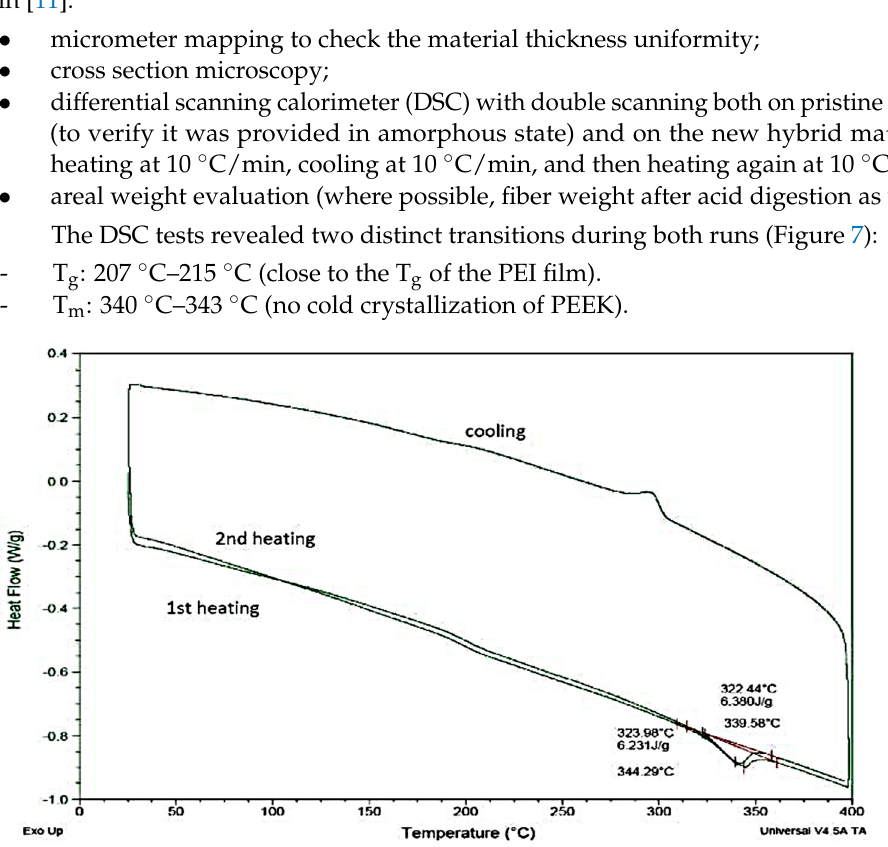
Figure 7. Two distinct transitions were revealed during the DSC test [11].